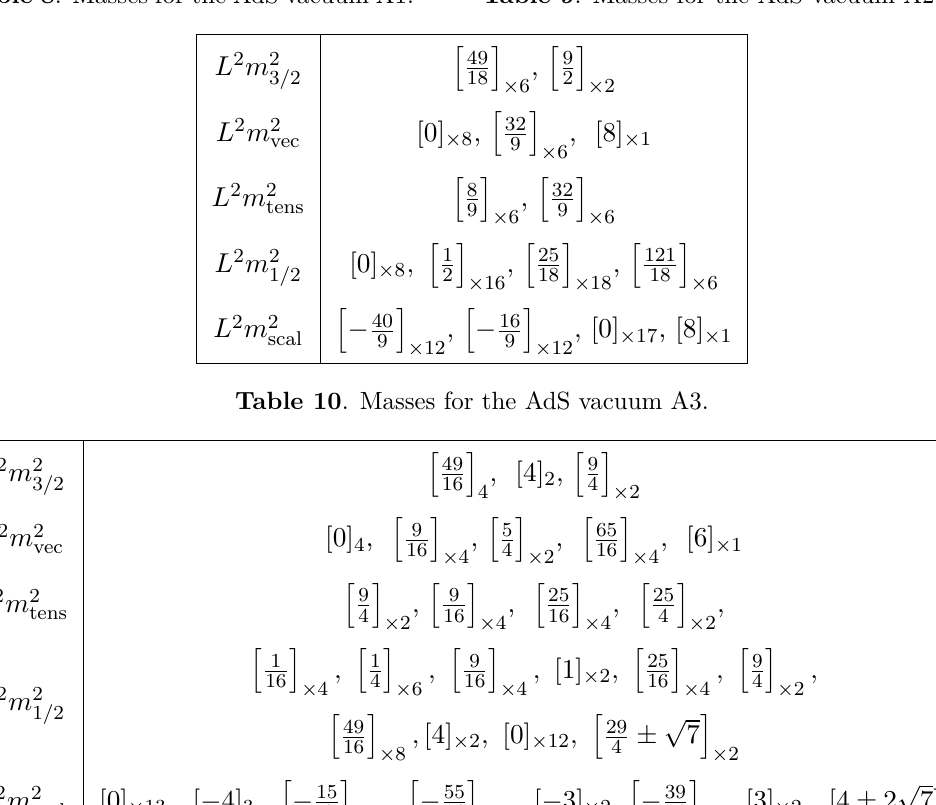
Table 8 . Masses for the AdS vacuum A1. Table 9 . Masses for the AdS vacuum A2.